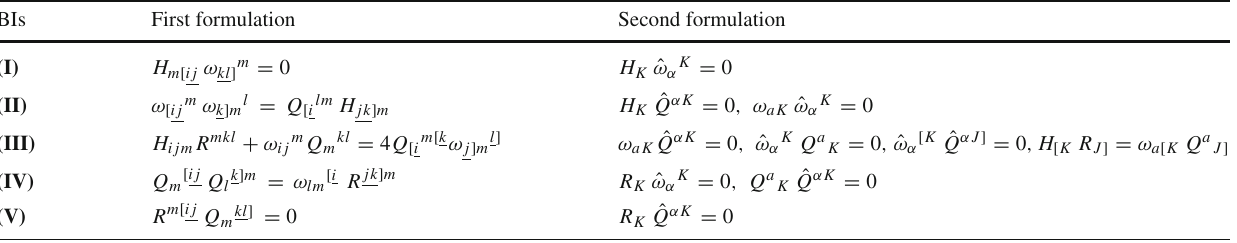
Table 6 A conjectural form for (some of) the missing identities. Here we have considered κ − 1 = 1 /κ abc and abc ˆ κ − 1 = 1 / ˆ κ a αβ for fixed values a αβ of { a , b , c } and { α,β } , whenever these intersections are non-zero, and similarly for the triple intersections on the mirror side